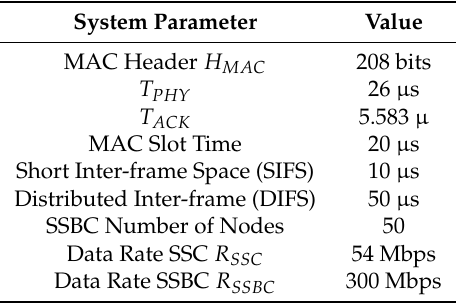
Table 2. IEEE 802.11 system parameters.